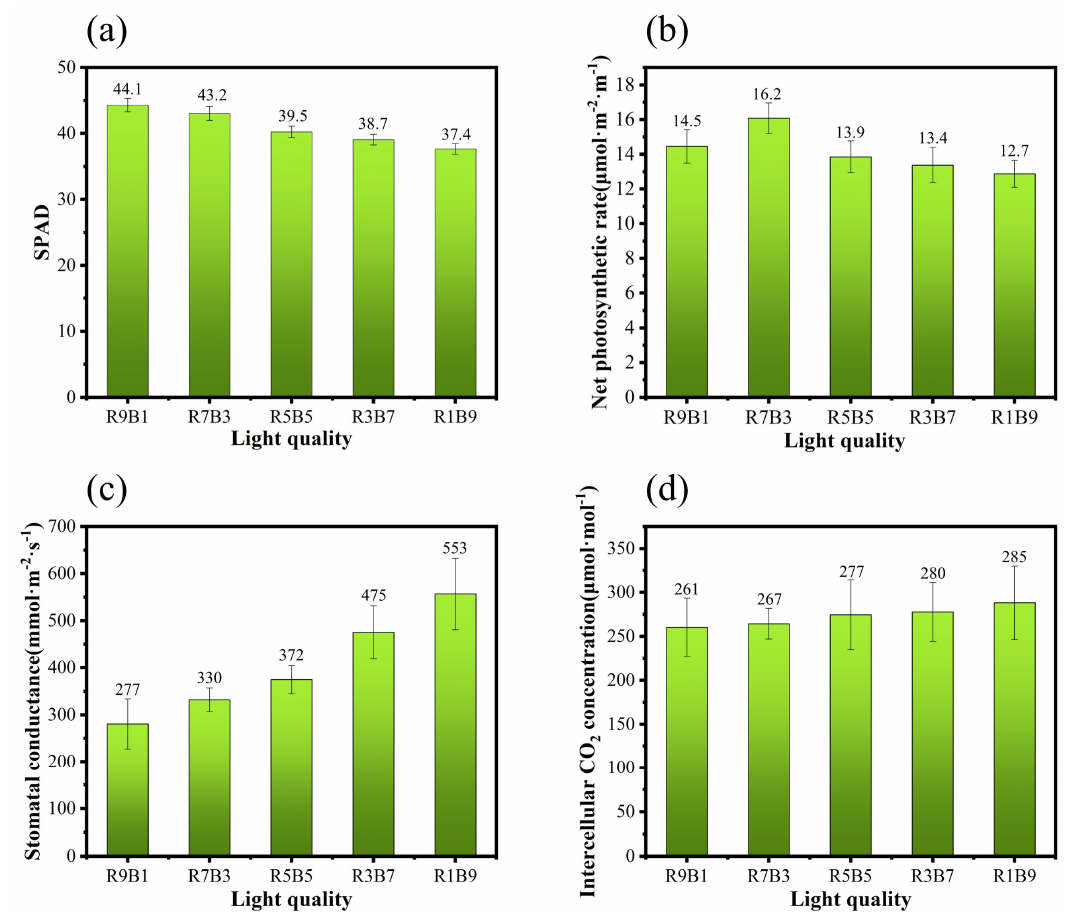
Figure 6. ( a ) Relative chlorophyll content of seedlings under different light qualities. ( b ) Net photosynthetic rate of seedlings under different light qualities. ( c ) Stomatal conductance of seedlings under different light qualities. ( d ) Intercellular carbon dioxide concentration of seedlings under different light qualities.